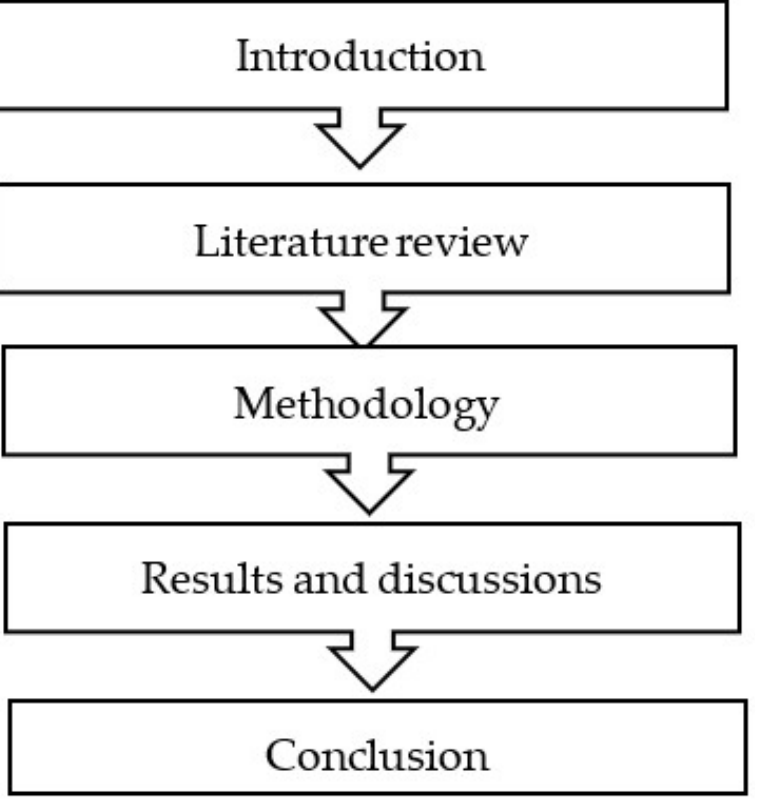
Figure 2. Flow chart of the paper.